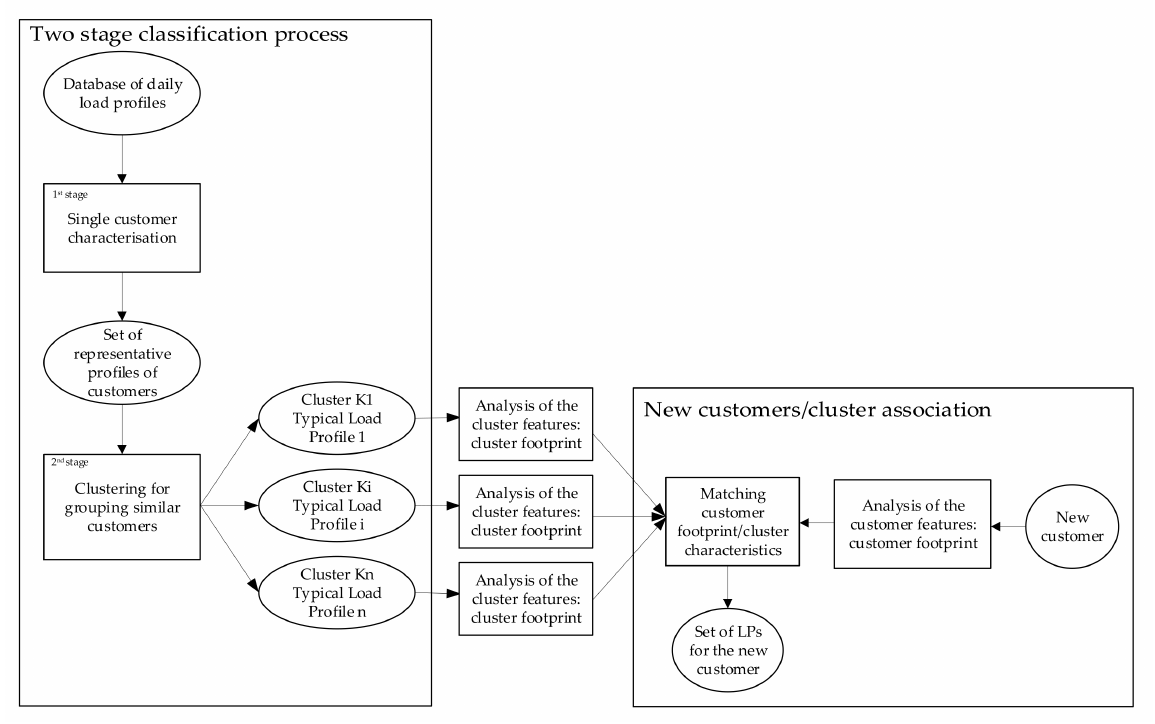
Figure 1. Flowchart of the proposed